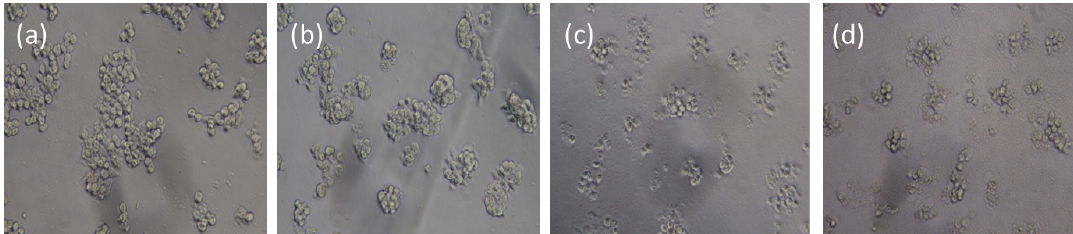
Figure 6. The viability of Human colon carcinoma (HT-29) cells: ( A ) treatment with IBN-4 loaded with Horseradish peroxidase (HRP) prepared via two synthetic routes; ( B ) treatment of IBN-4-HRP synthesized using two different routes in the presence or absence of indole-3-acetic acid (IAA) (IAA expressed in µM); and ( C ) treatment of various concentrations (200 and 500 μg/mL ) of IBN-4-HRP synthesized in the presence or absence of IAA (IAA expressed in µM).